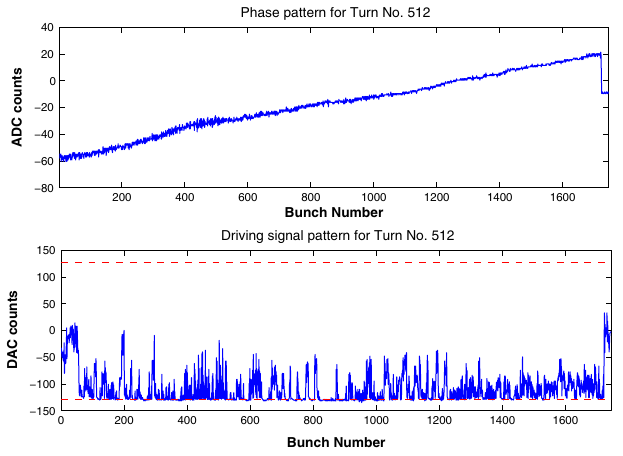
FIG. 14. (Color) Front-end and back-end signal of the longitu- dinal feedback system for turn 512 of the time sequence shown in Figs. 8 and 9. At this moment, roughly 1 = 2 a synchrotron cycle later than Fig. 10, the kick signal is almost completely saturated at the negative full-scale value of (cid:2) 128 .